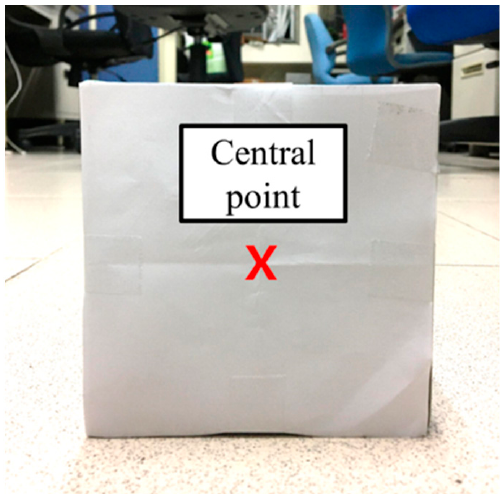
Figure 21. Target of Condition 1, target is located at the center (cross mark).